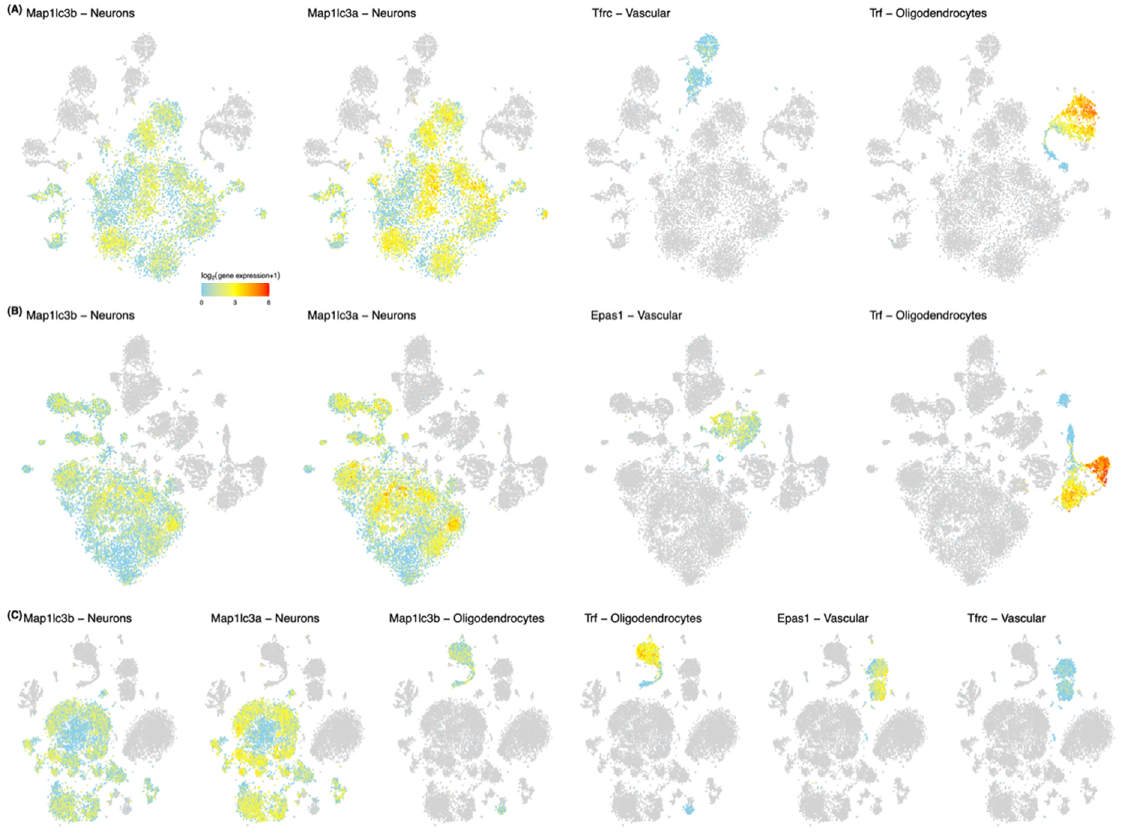
Figure 3. Ferroptosis gene expressions in the cortices of the adolescent mouse brain. Distributions of FR genes were described for various cell types in the mouse brain. Cell types, including neurons, oligodendrocytes, or other non-neuronal cells are described as a cluster of cells using the t-distributed stochastic neighbor embedding (t-SNE), a probabilistic method for visualizing high dimensional single cell RNA-sequencing data. Among FR genes that are converted to mouse genes, five genes ( Epas1 , Map1lc3a , Map1lc3b , Tfrc , Trf ) with postnatal rising trajectory were used. Only clusters with markers that intersected with FR genes are colored, according to the expression levels, which are log 2 transformed. Clusters that are not of interest in each plot are colored in light gray. ( A ) t-SNE plot in anterior cortex; ( B ) middle cortex; ( C ) posterior cortex.